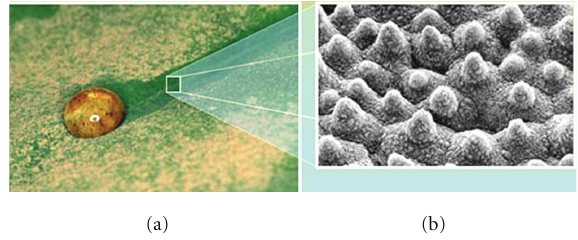
Figure 7: (a) Water rolls across a leaf without sticking at all and carries away dirt; (b) microscopic bumps (a few microns in size) all across the leaf’s surface hold the key to its water-repelling